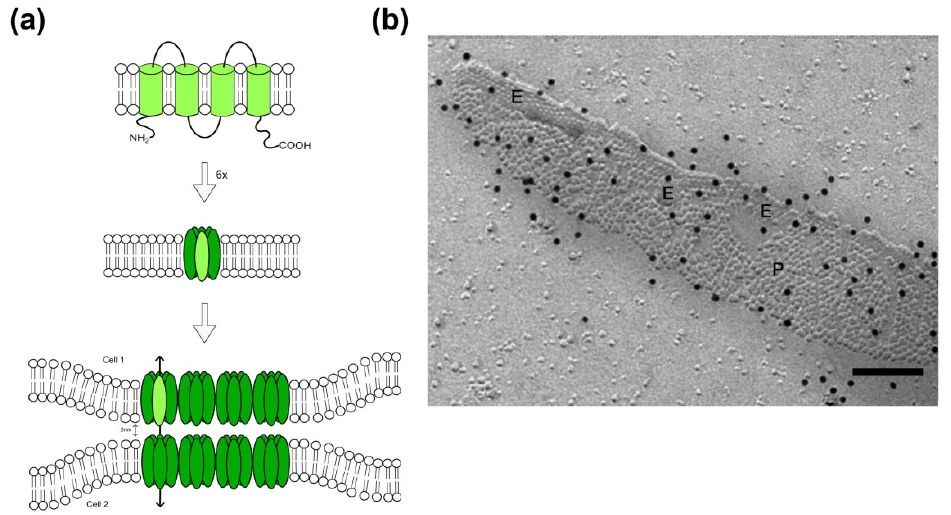
Figure 1. Assembly of connexin proteins to form gap junctions within the plasma membrane of eukaryotes. ( a ) Connexin proteins insert with four transmembrane domains (upper panel; light green) in the plasma membrane of cells. Six connexins oligomerize and form a transmembrane channel (middle panel; hemichannel in green, a single connexin protein is highlighted in light green). Hemichannel-containing membranes of adjacent cells converge to 2 nm, forming an intercellular gap junction. Schematic drawings are not to scale. ( b ) Connexin-gap junction, here shown in the membrane of cultured murine primary astrocytes, display as hexagonally structured plaque in freeze-fracture replicas with particle-rich areas (P-face, P) and areas with pits (E-face, E). Black dots represent Cx43-immunosignal after labeling with 12 nm colloidal gold-coupled secondary antibodies. Scale bar 100 nm.